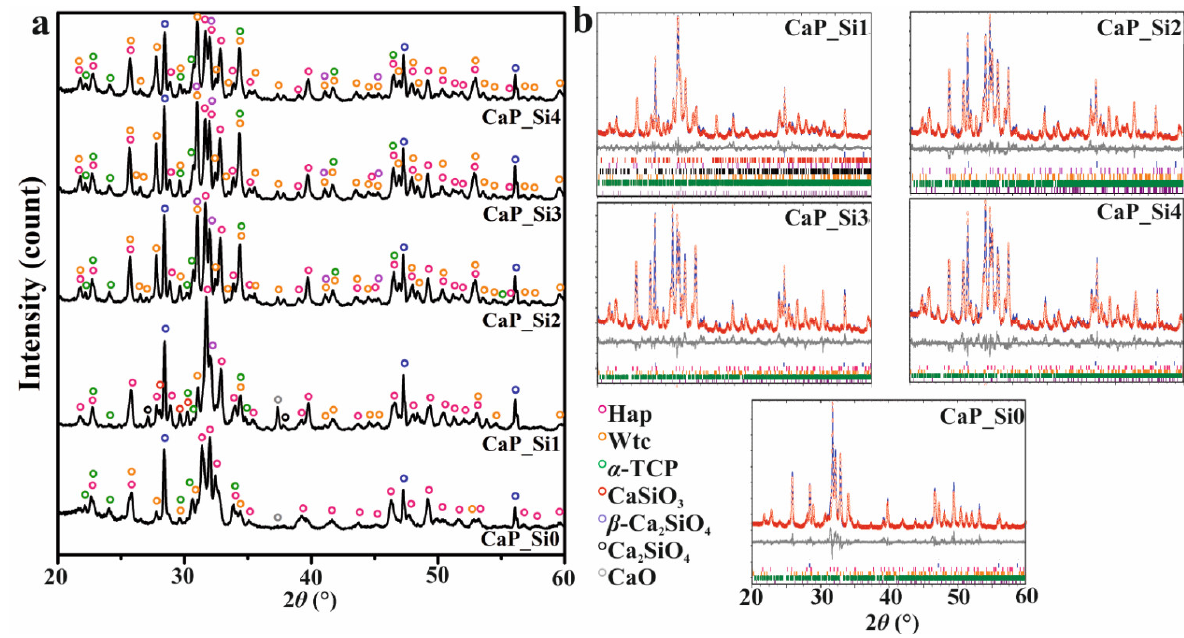
Figure 2. X-ray diffraction data of the prepared calcium phosphate scaffolds doped with silicon ( a ). Whole-powder-pattern decomposition analysis of scaffolds’ X-ray diffraction data ( b ). The solid lines (blue) are calculated data intensities, and open circles are (red) experimental data intensities. The difference between the calculated and experimental intensities is plotted below the XRD profile. Bragg positions of HAp (pink), Wtc (orange), α -TCP (green), CaSiO 3 (red), β -Ca 2 SiO 4 (purple), Ca 2 SiO 4 (black), CaO (gray) and silicon (blue, standard) are marked for each pattern. Table 1. Quantitative analysis of calcium phosphate and calcium silicate phases in prepared scaffolds performed by whole-powder-pattern decomposition